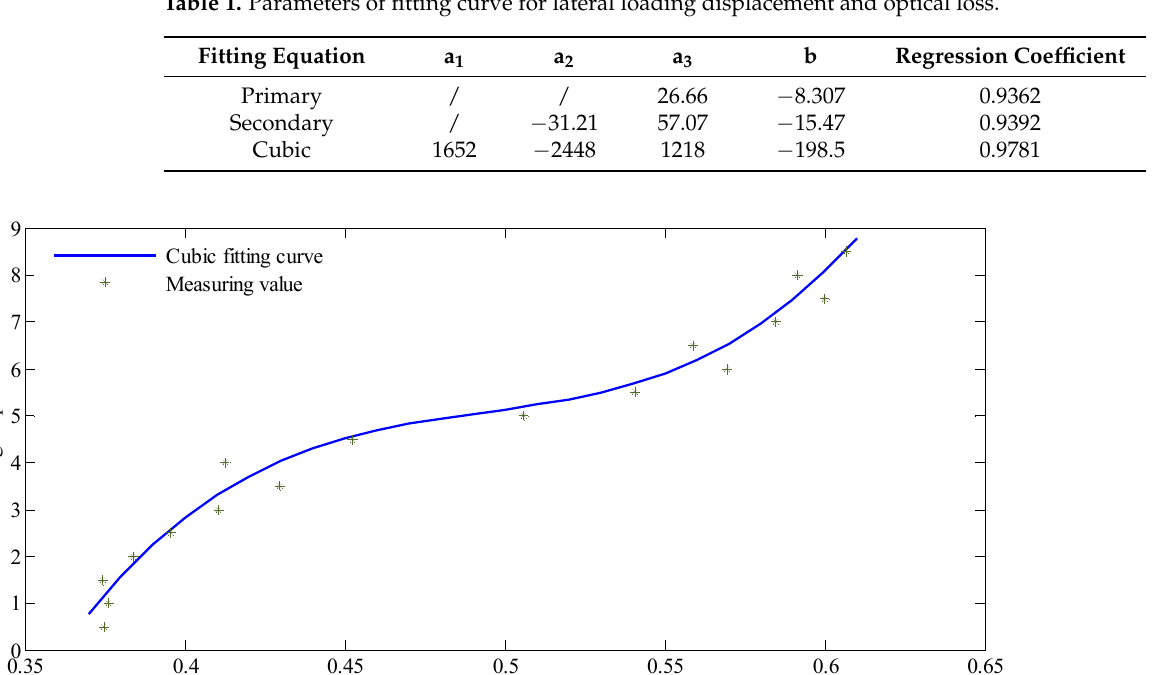
Table 1. Parameters of fitting curve for lateral loading displacement and optical loss.